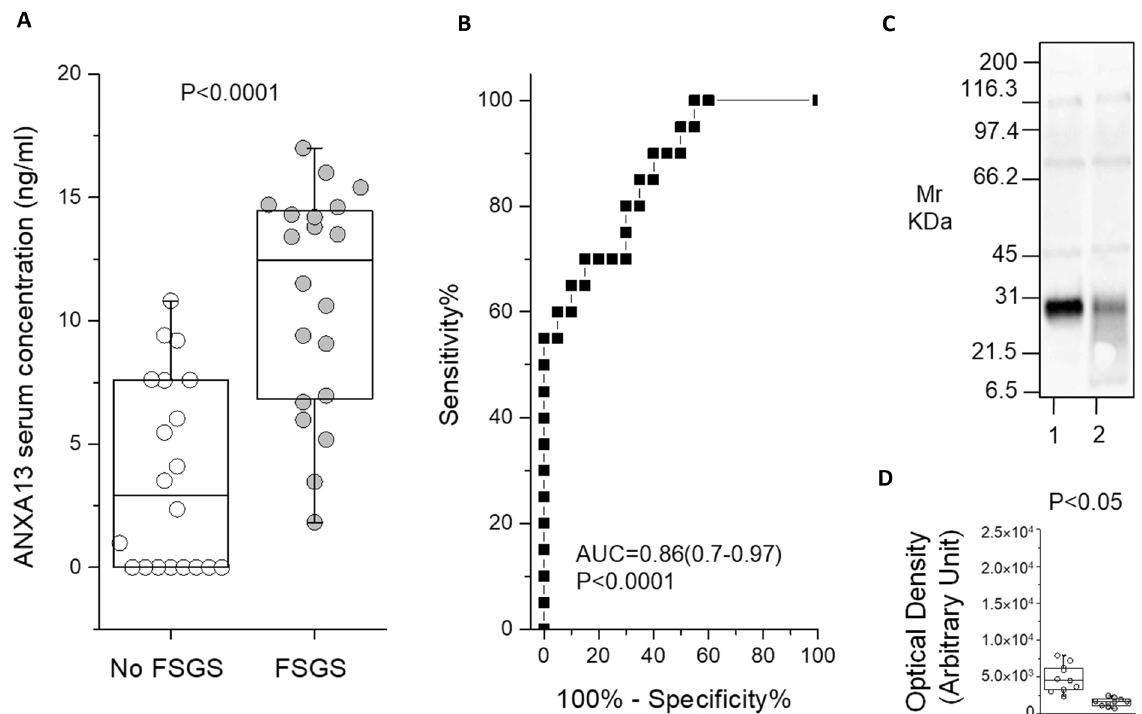
Figure 3. ANXA13 ELISA assay and TIMP1 western blot. ( A ) Box plot showing the median and interquartile range value of serum ANXA13 protein in an independent patients’ cohort. ANXA13 are more abundant in FSGS (grey circles) compared to No FSGS (white circles) patients ( p < 0.0001); ( B ) ROC curve analysis for ANXA13 assay. ( C ) and ( D ) Representative western blot analysis of full length gel (8–16 T%) for TIMP1 in exosomes from with No FSGS (lane 1 or white circles) or FSGS (lane 2 or grey circles) and its densitometry analysis visualized as box plot (20 independent patients’ cohort). TIMP1 is more abundant in No FSGS compared to FSGS patients ( p <